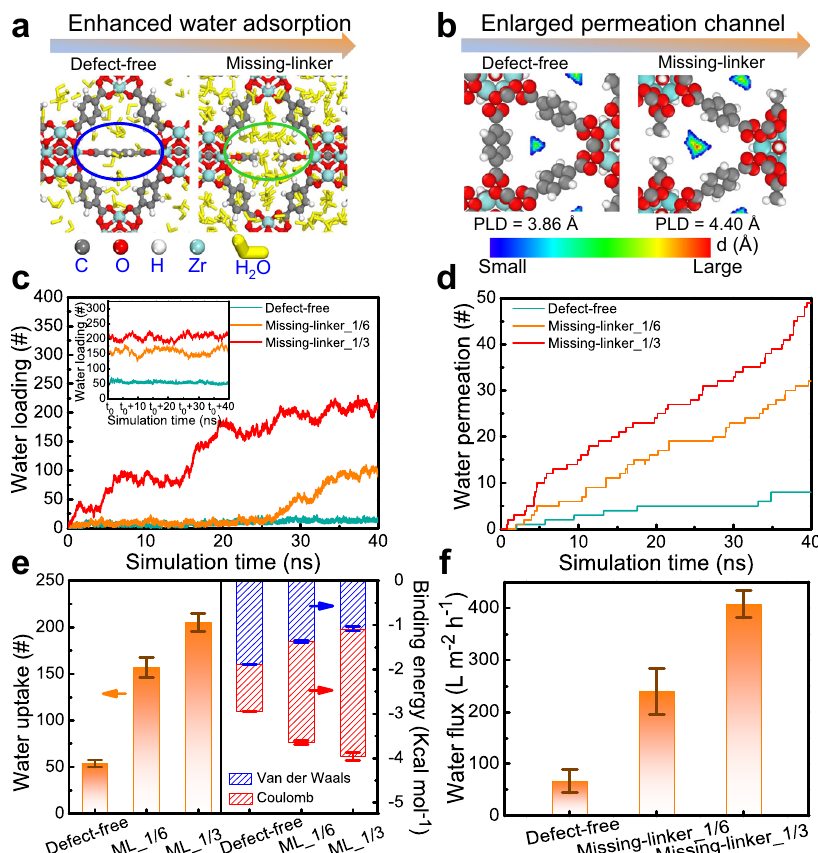
Fig. 5 Molecular dynamics simulations of water molecule transport through UiO-66 or ML-UiO-66 membranes during a PV process. a Schematic diagram of defect-enhanced adsorption of water molecules in UiO-66 and ML-UiO-66 structure. b Two-dimensional schematic diagram of different sub- nanometer channels for water molecule transport in UiO-66 and ML-UiO-66 structure using pore limiting diameter (PLD) as an evaluation indicator (Note: warmer colors toward red indicates a larger distance. See Supplementary Fig. 29 for more details.) c Dynamic adsorption process (i.e., simulated adsorption isotherm curves) of water molecules in UiO-66 and ML-UiO-66 membranes as a function of simulation time (the inset indicates the number of water molecules in UiO-66 and ML-UiO-66 membranes as a function of simulation time after adsorption equilibrium i.e., denoted as t 0 ). d Number of permeated water molecules across UiO-66 and ML-UiO-66 membranes as a function of simulation time. e Left : Number of water molecules residing in UiO-66 and ML-UiO-66 membranes after adsorption equilibrium (ML: missing linker); Right : Binding energy (Van der Waals and Coulombic contributions) between water molecule and the UiO-66/ML-UiO-66 structure. A more negative binding energy value represents a stronger attractive interaction. Details of the binding energy calculations can be seen in the Supplementary Information. f Simulated water fl ux of UiO-66 and ML-UiO-66 membranes. (Numbers that follows the ±signs are standard deviation (SD) in this